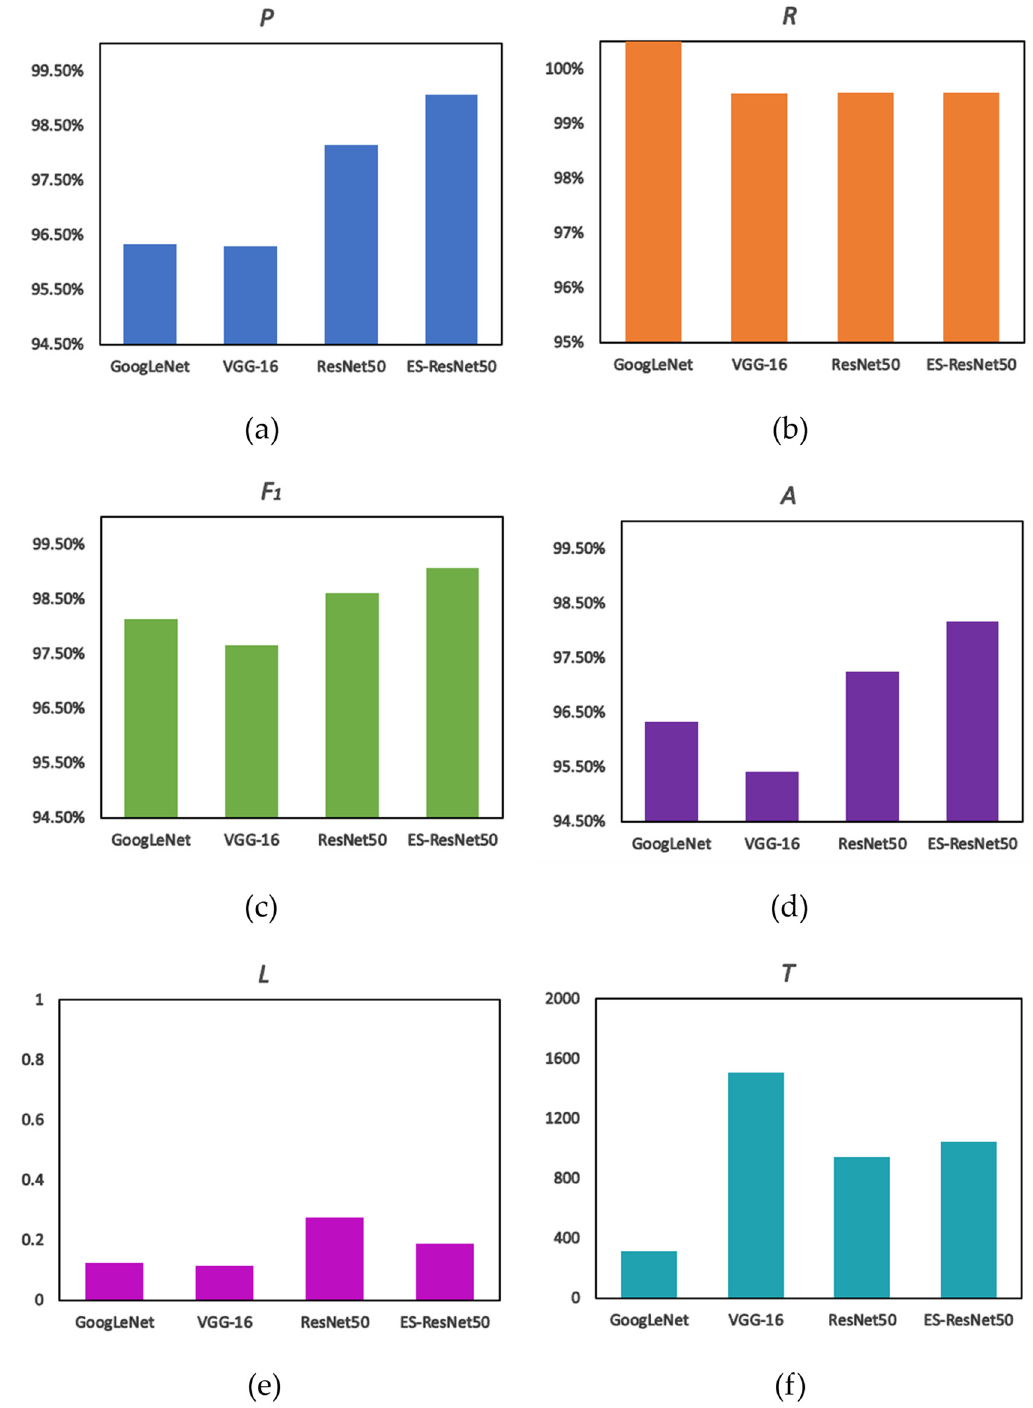
Figure 12. Performance comparison of four networks: where ( a – f ) are separately precision, recall, F 1 -score, validation accuracy, validation loss, and training time.